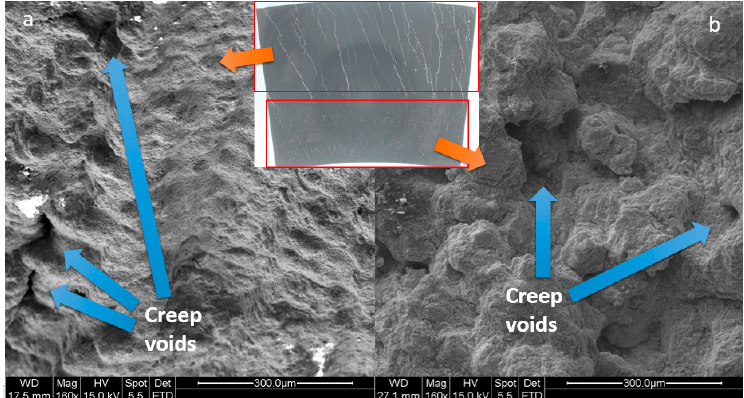
Figure 7. Fracture surface in ( a ) dendritic and ( b ) equiaxed grain regions.